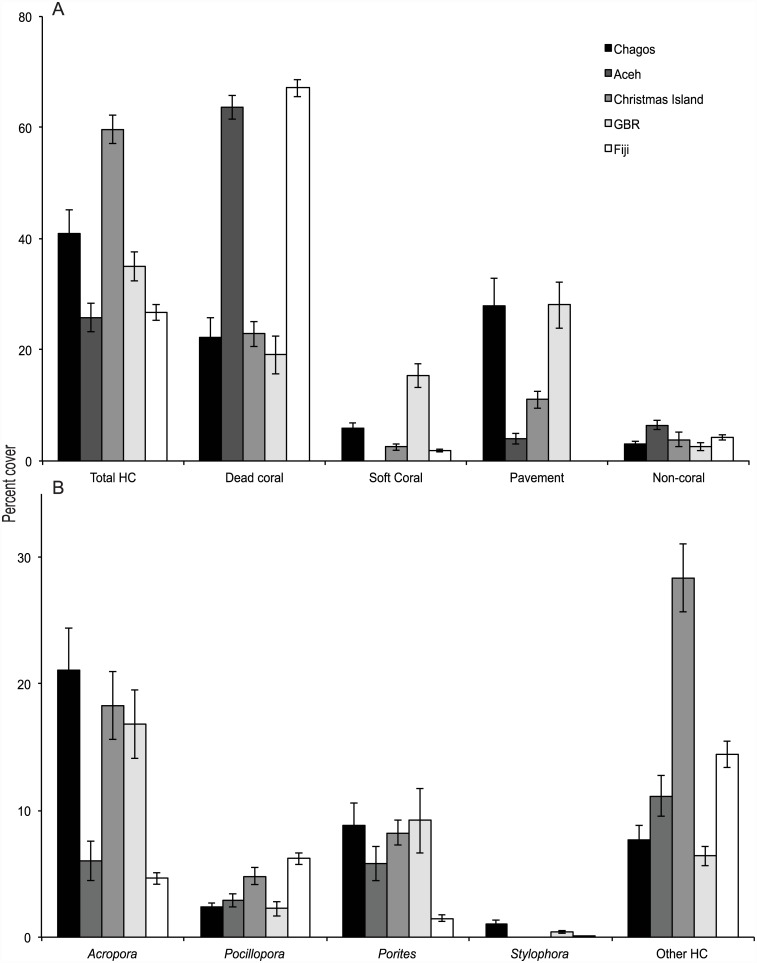
Mean percentage cover (± SE) of habitat categories at six study locations.(A) Three non-live scleractinian categories, soft coral, and pooled live hard coral (Total HC). (B) Four common coral genera and pooled other hard live corals (Other HC). Means for each location calculated from transects across all reefs.